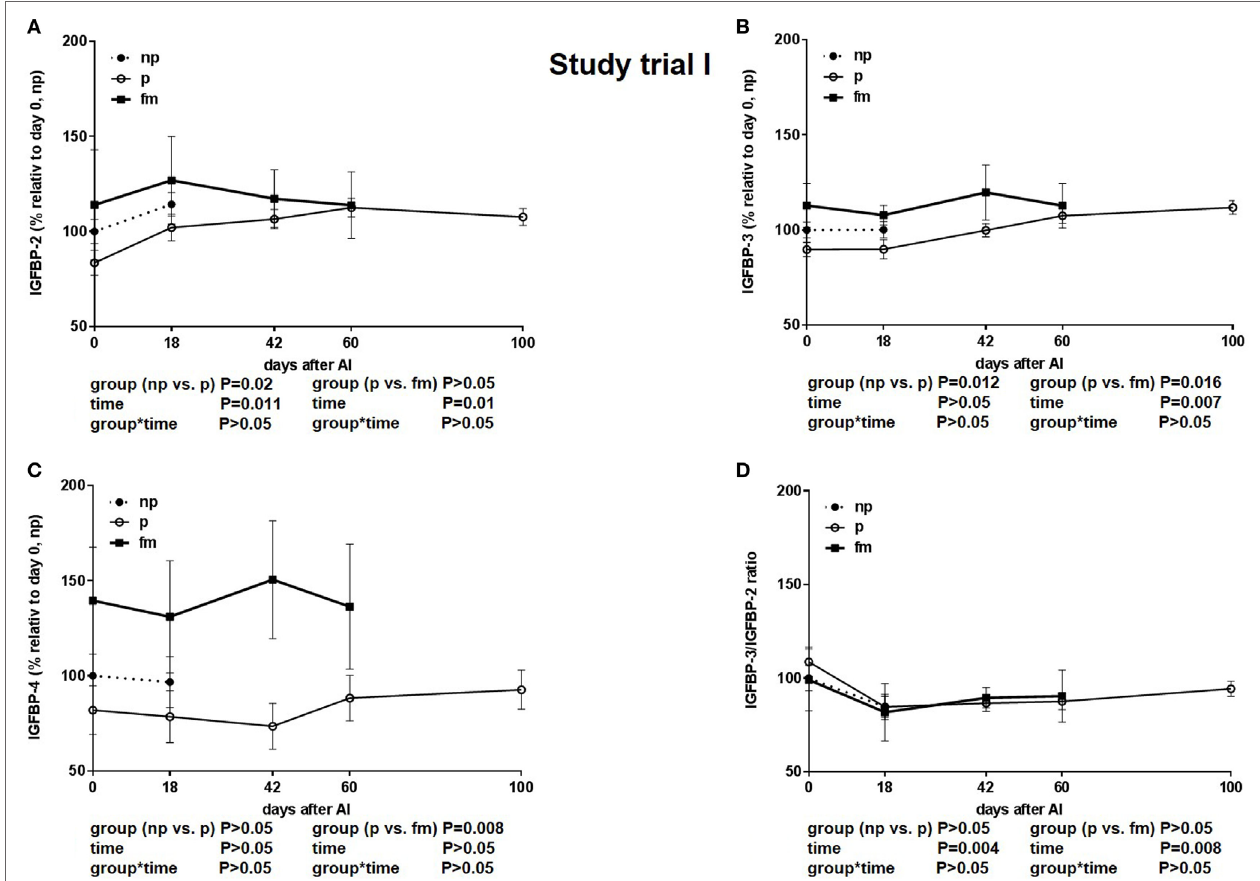
FigUre 3 | Study trial I: insulin-like growth factor-binding protein (IGFBP) (a) : -2, (B) : -3 and (c) : -4 concentration and (D) : IGFBP-3/IGFBP-2 ratio in not-pregnant [np, n = 43, day of AI (0) and 18 days after AI] and pregnant (p, n = 34, day of AI, and 18, 42, 60 and 100 days after AI) pluriparous Holstein–Friesian cows as well as cows with fetal mortality (fm, n = 4, day of AI and until day 60 after AI). Values are given in% relative to day 0 of non-pregnant cows. Values are given as mean ±